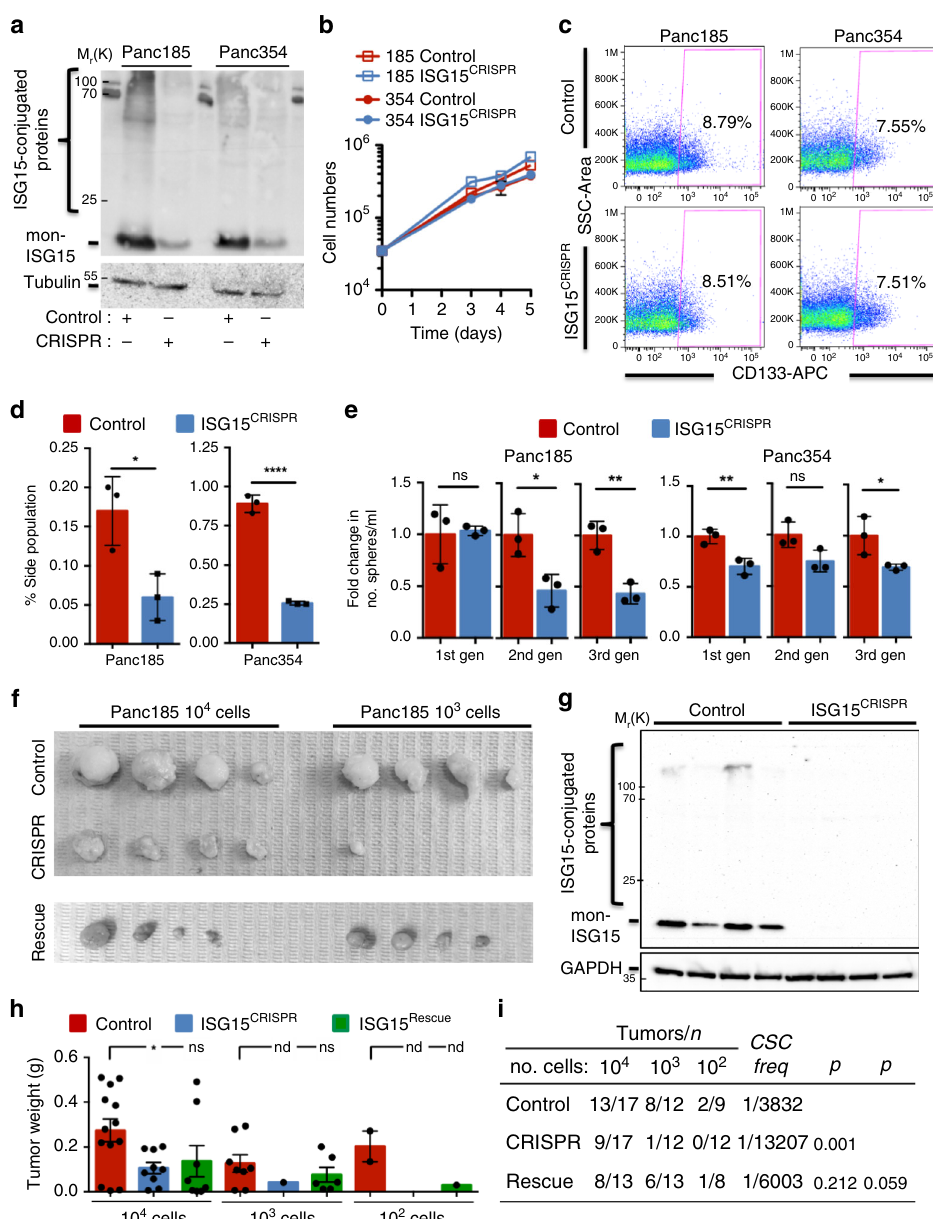
Fig. 3 Loss of ISG15/ISGylation affects PaCSC functional properties. a WB analysis of mon-ISG15 and ISG15-conjugated proteins after CRISPR-Cas9 ISG15 editing (CRISPR) in two different primary PDAC PDX cultures. Tubulin was used as loading control. b Proliferation of control and ISG15 CRISPR Panc185 and Panc354 cells, graphed as mean cell numbers ± sd determined at the indicated days post seeding ( n = 3 biologically independent samples). c Representative fl ow cytometry plots for CD133 expression in control and ISG15 CRISPR Panc185 and Panc354 cells. d Mean percent of Hoechst non- retaining cells (i.e., side population) ± sd in control and ISG15 CRISPR Panc185 and Panc354 cells ( n = 3 biologically independent samples; * p = 0.0227; **** p < 0.0001, as determined by Student ’ s t -test). e Mean fold change ± sd of 1st, 2nd, and 3rd generation (gen) sphere formation capacity of control versus ISG15 CRISPR cells (Panc185: n = 3 biologically independent samples; * p = 0.0230; ** p = 0.0044; ns not signi fi cant, as determined by Student ’ s t -test; and Panc354: n = 3 biologically independent samples; * p = 0.0482; ** p = 0.0090; ns, not signi fi cant, as determined by Student ’ s t- test). Control set as 1.0. f Images o f tumors obtained after injection of 10 4 and 10 3 Panc185 control, ISG15 CRISPR and ISG15 Rescue (ISG15 CRISPR + ISG15-V5-GFP, E1, E2, and E3 overexpression) (Rescue) cells. g WB analysis of mon-ISG15 and ISG15-conjugated proteins in freshly digested 10 4 tumors obtained from f . GAPDH was used as loading control. h – i Average tumor weights ± sem ( n = indicated in i ; * p = 0.0172; ns, not signi fi cant, as determined by Student ’ s t -test; nd, not determined) ( h ) and total number of tumors obtained from control, ISG15 CRISPR and ISG15 Rescue injections from three independent in vivo ELDA animal experiments ( i ). CSCs frequencies were calculated using the Extreme Limiting Dilution Analysis